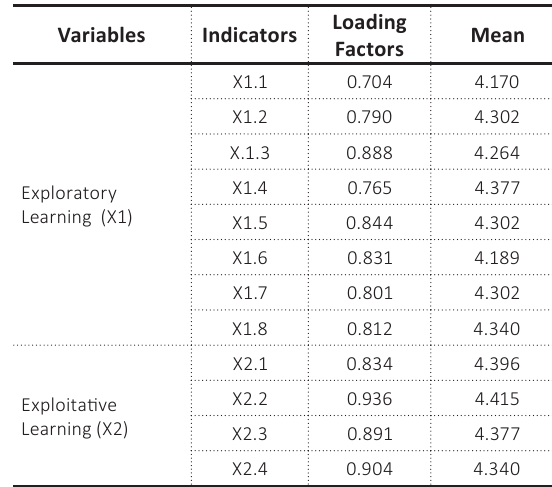
Table 2. Research variable